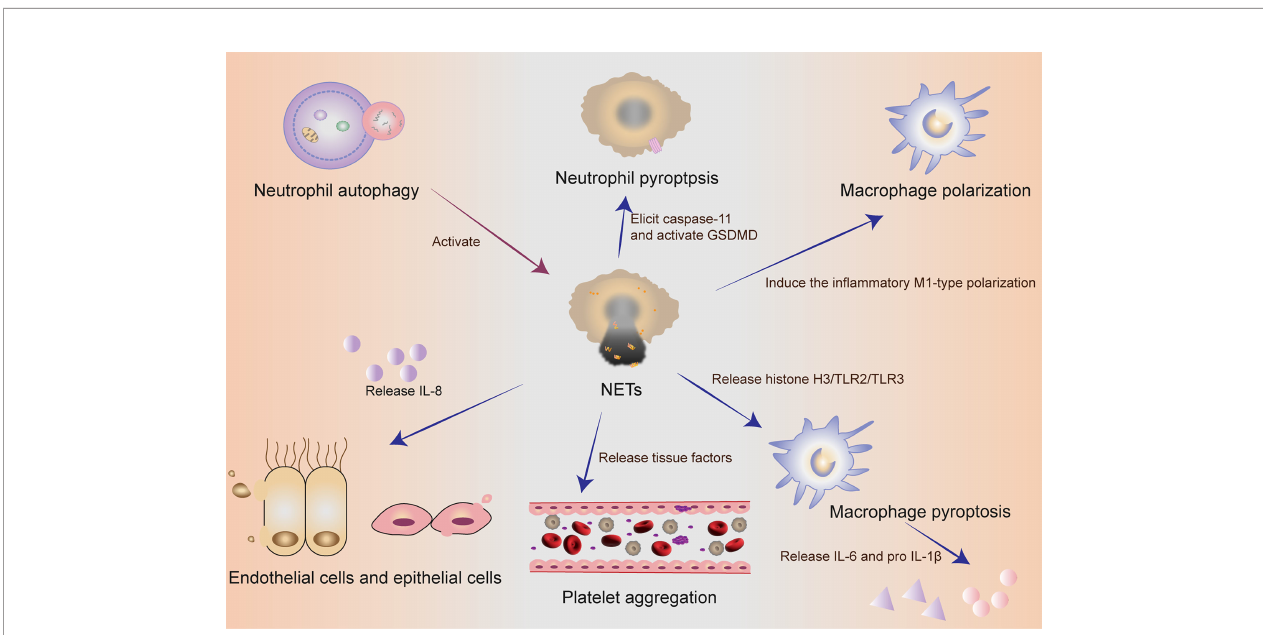
FIGURE 2 | The collaboration of different cells in self-sacri fi ce. Neutrophil autophagy could subsequently activate NETs. Neutrophils used an in fl ammasome and GSDMD-dependent mechanism to activate NETosis. NETs could induce the pro-in fl ammatory M1-type polarization of lung tissue macrophages, thus aggravating lung injury. NETs could promote pyroptosis of macrophages, which could exacerbate the in fl ammatory response of sepsis. Activated endothelial cells induced NETs through IL-8 resulting in severe tissue damage. NETs and their components are cytotoxic and can directly kill endothelial and epithelial cells. During the formation of NETs, tissue factors can be produced and released, thereby activating the coagulation cascade and simultaneously stimulating platelet activation, leading to platelet aggregation and ultimately thrombosis. NETs, neutrophil extracellular traps; GSDMD, gasdermin D; IL,